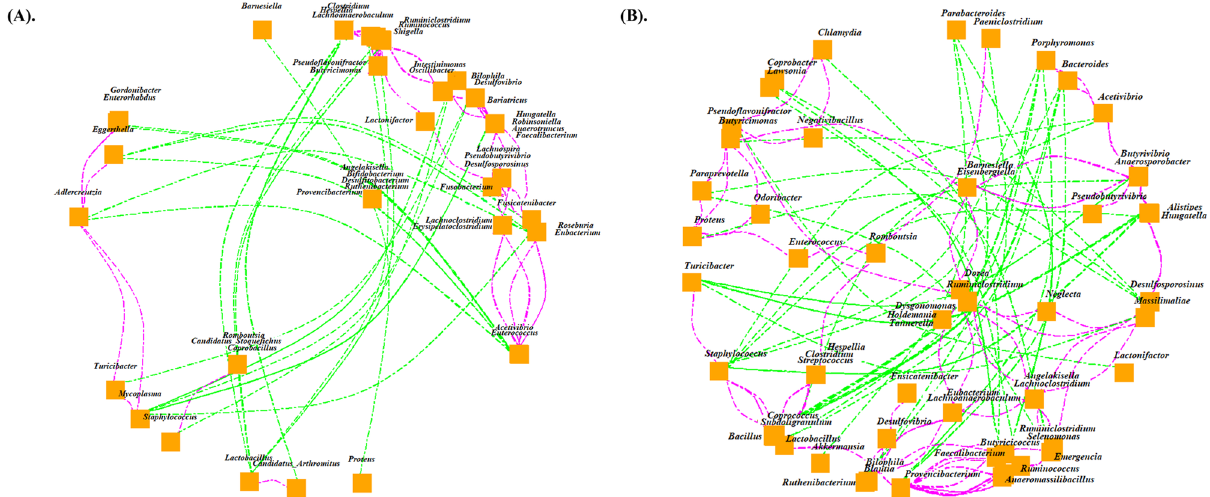
Figure 5. Co-occurrence analysis revealed differences in the concerted action of the gut microbial community in different diet compositions. Taxa correlation network plot in ( A ) GB and ( B ) PIB groups.